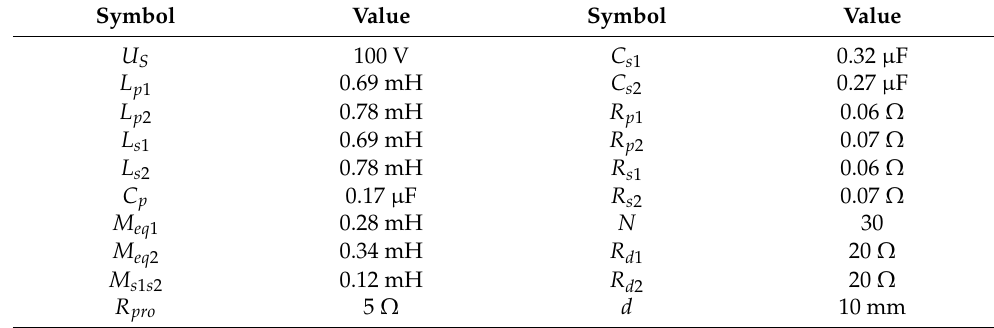
Table 3. MIMO system prototype parameters.